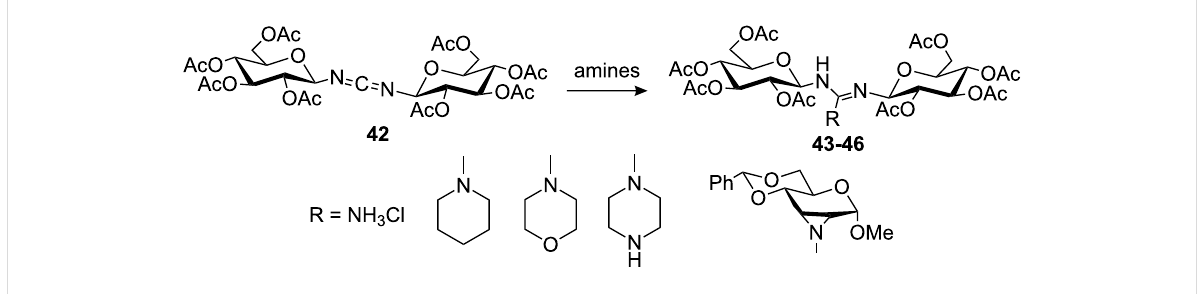
Tóth and co-workers [90] synthesised a series of guanidine- linked sugars as a new class of oligosaccharide mimics to study their interactions with proteins. Thus, reaction of the carbod- iimide-linked pseudooligosaccharide 42 with different secondary amines gave the corresponding guanidines 43 – 46 (Scheme 5) and their conformational behaviour and tauto- merism was studied by NMR spectroscopy.